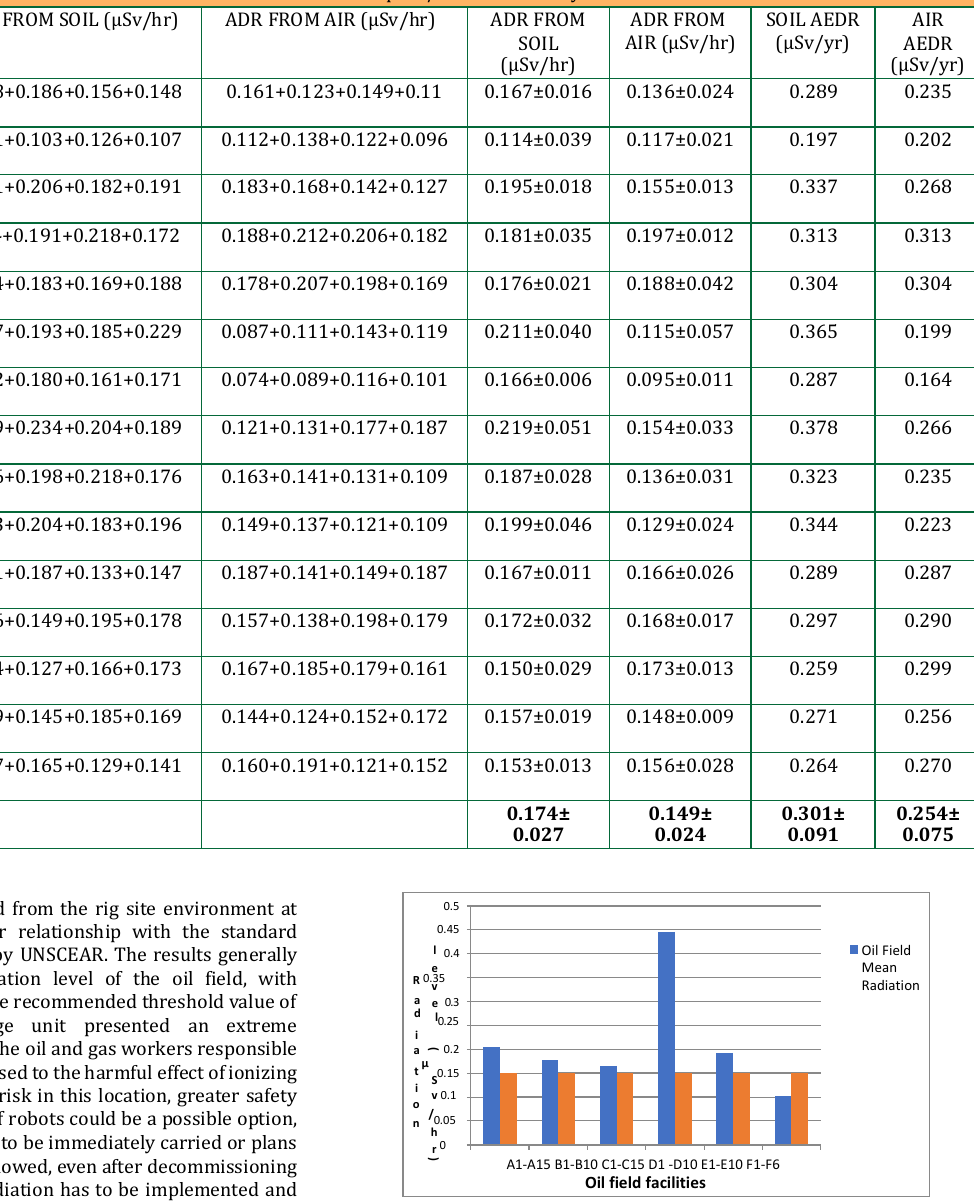
Figure 3: Correlation of mean radiation levels (μSv/hr) with the standard background radiation in the Eruemukohwarien oil field.